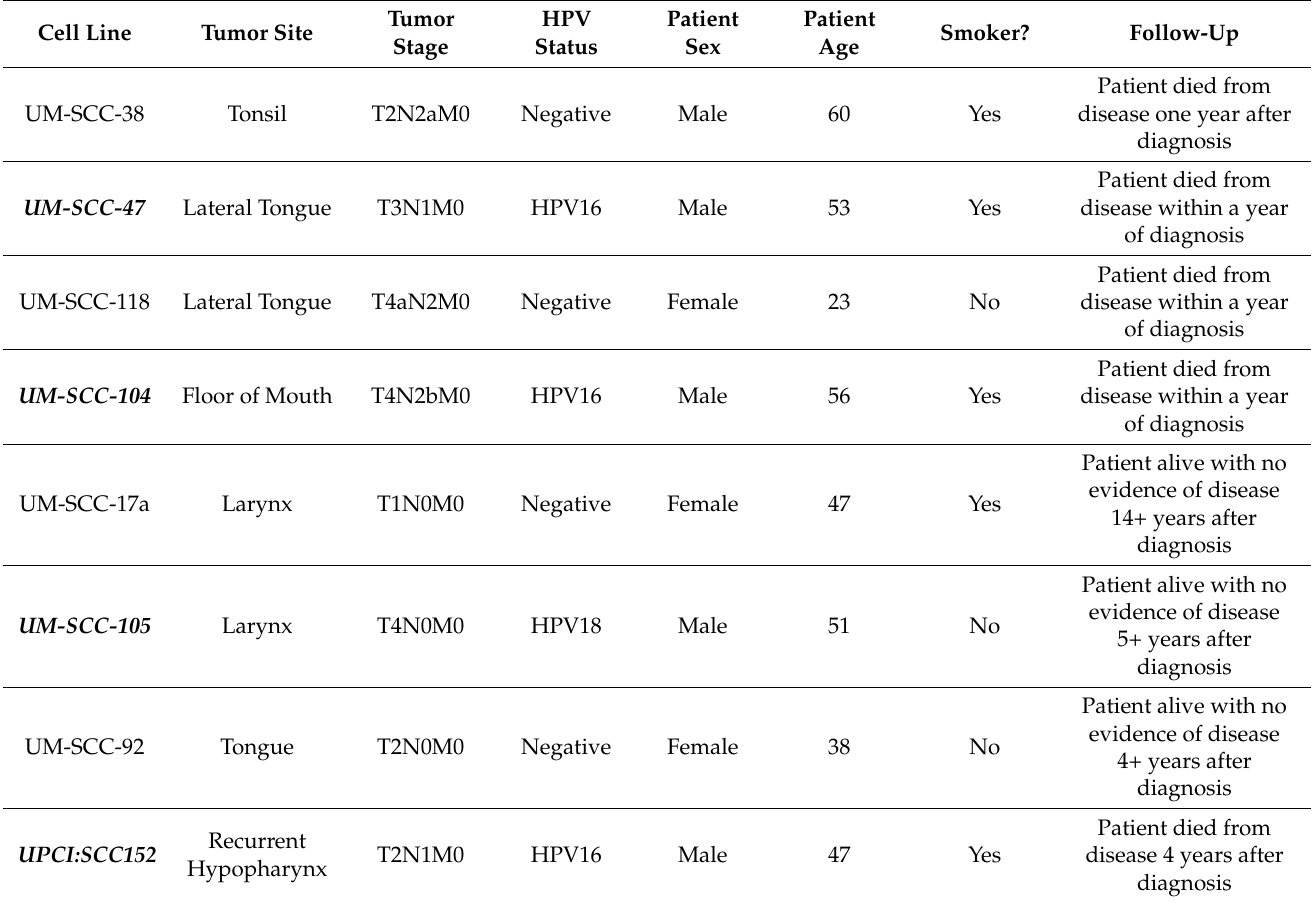
Table 1. Head and Neck Squamous Cell Carcinoma Lines Used in the Study. Bold italics: HPV-positive. Cell